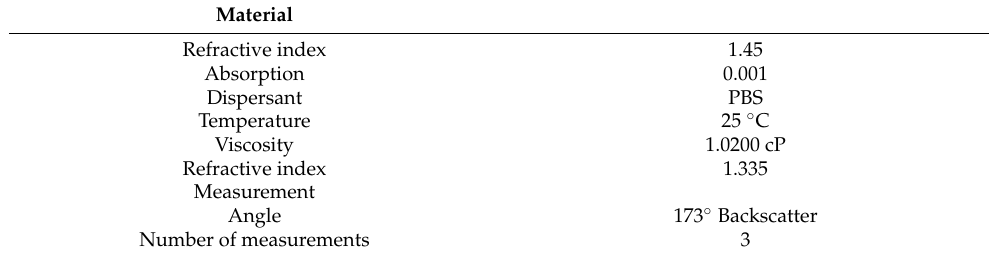
Table 1. Parameters used for DLS analysis of liposomal nanomaterials, recorded using Malvern Zetasizer